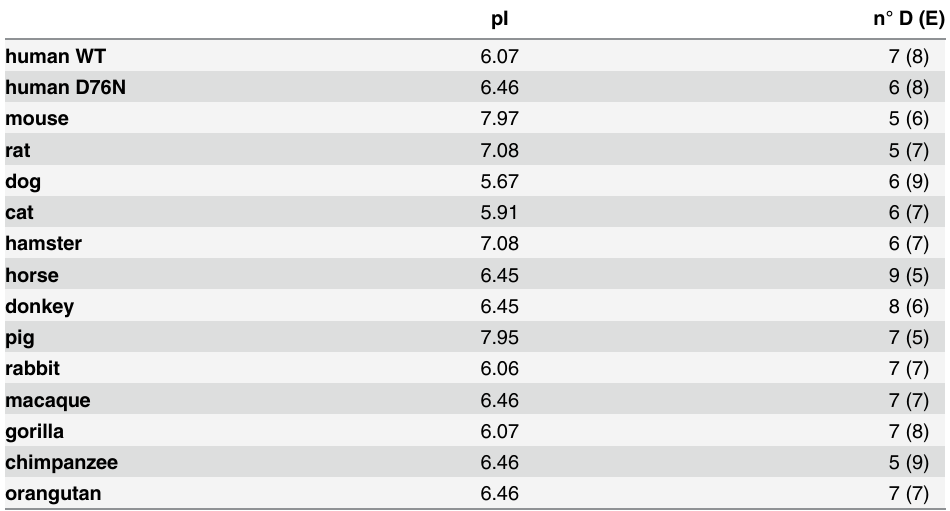
Table 1. Theoretical isoelectric points for mammalian wt β 2m ’ s and the human D76N variant. The number of D (E) residues is also reported. pI n° D (E) human WT 6.07 7 (8) human D76N 6.46 6 (8) mouse 7.97 rat 7.08 5 (7) dog 5.67 6 (9) cat 5.91 hamster 7.08 6 (7) horse 6.45 9 (5) donkey 6.45 8 (6) pig 7.95 7 (5) rabbit 6.06 7 (7) macaque 6.46 7 (7) gorilla 6.07 7 (8) chimpanzee 6.46 5 (9) orangutan 6.46 7